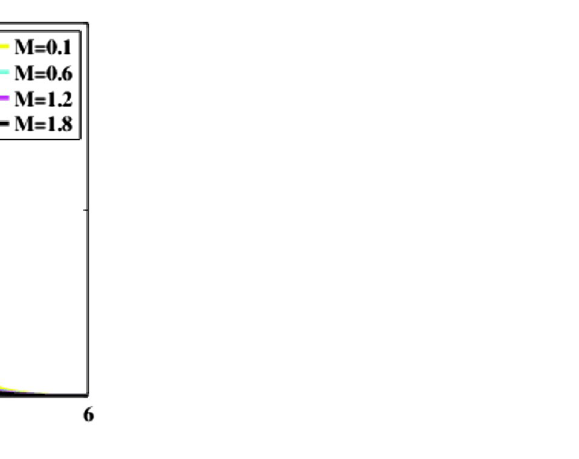
Figure 10. Plots of f